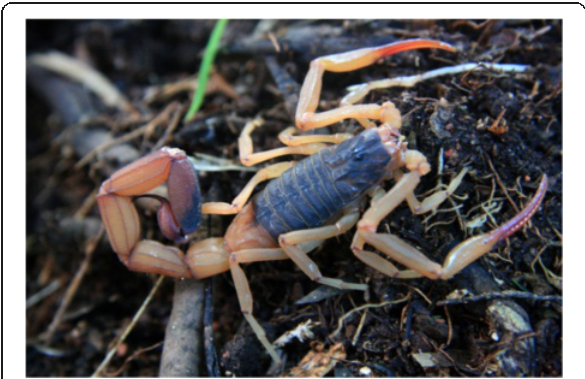
Fig. 20 Tityus ( Tityus ) melici Lourenço, 2003; male from Brazil (copyright by Tiago Porto, reproduced with permission)